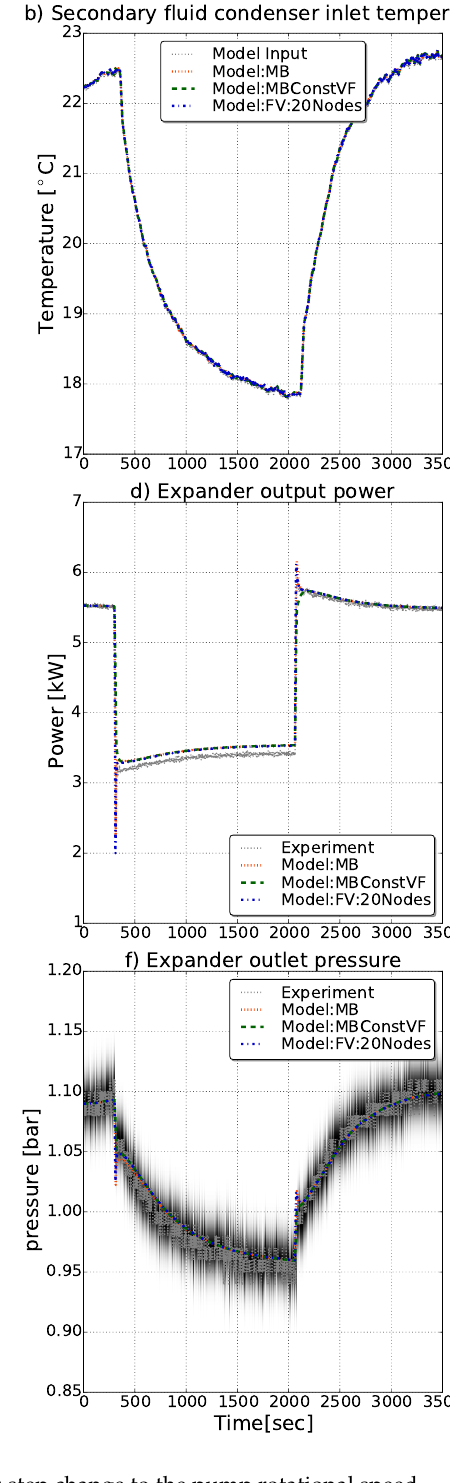
Figure 4. Downward-upward 5-Hz step change to the pump rotational